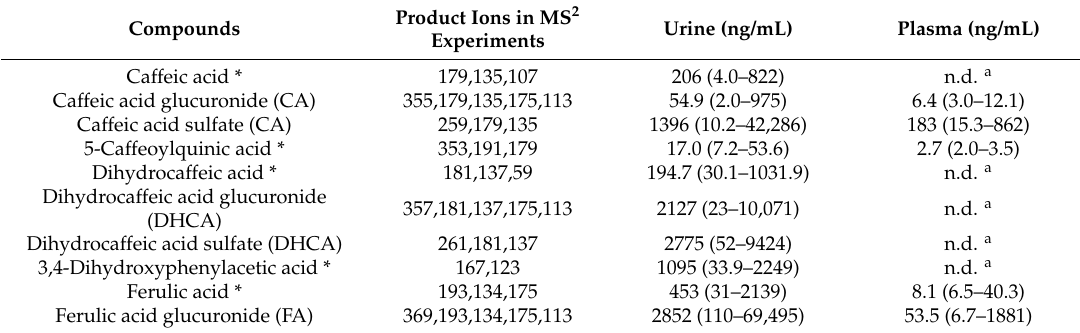
Table 4. Phenolic compounds and metabolites quantified in urine and plasma by UHPLC-MS/MS.